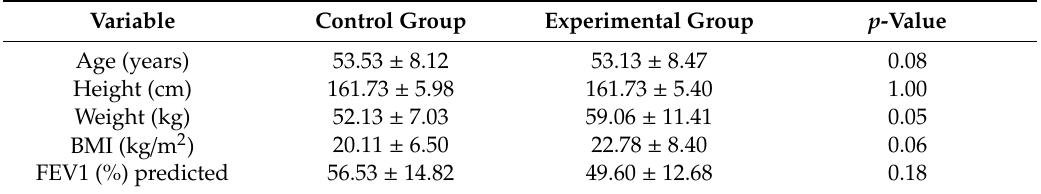
Table 1. Demographic data: experimental and control groups, n = 15 each (mean ± SD).